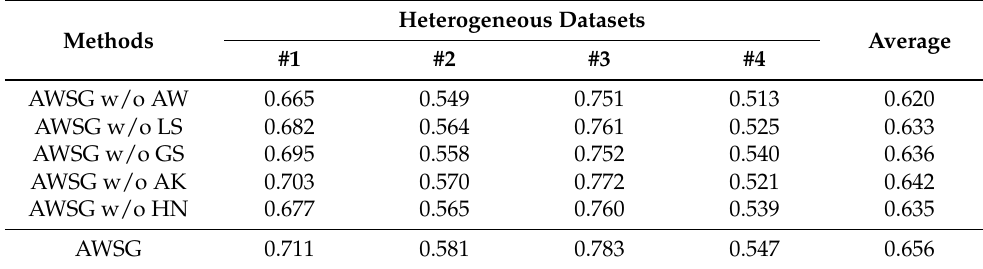
Table 3. Ablation study of AWSG measured by the F1 score of